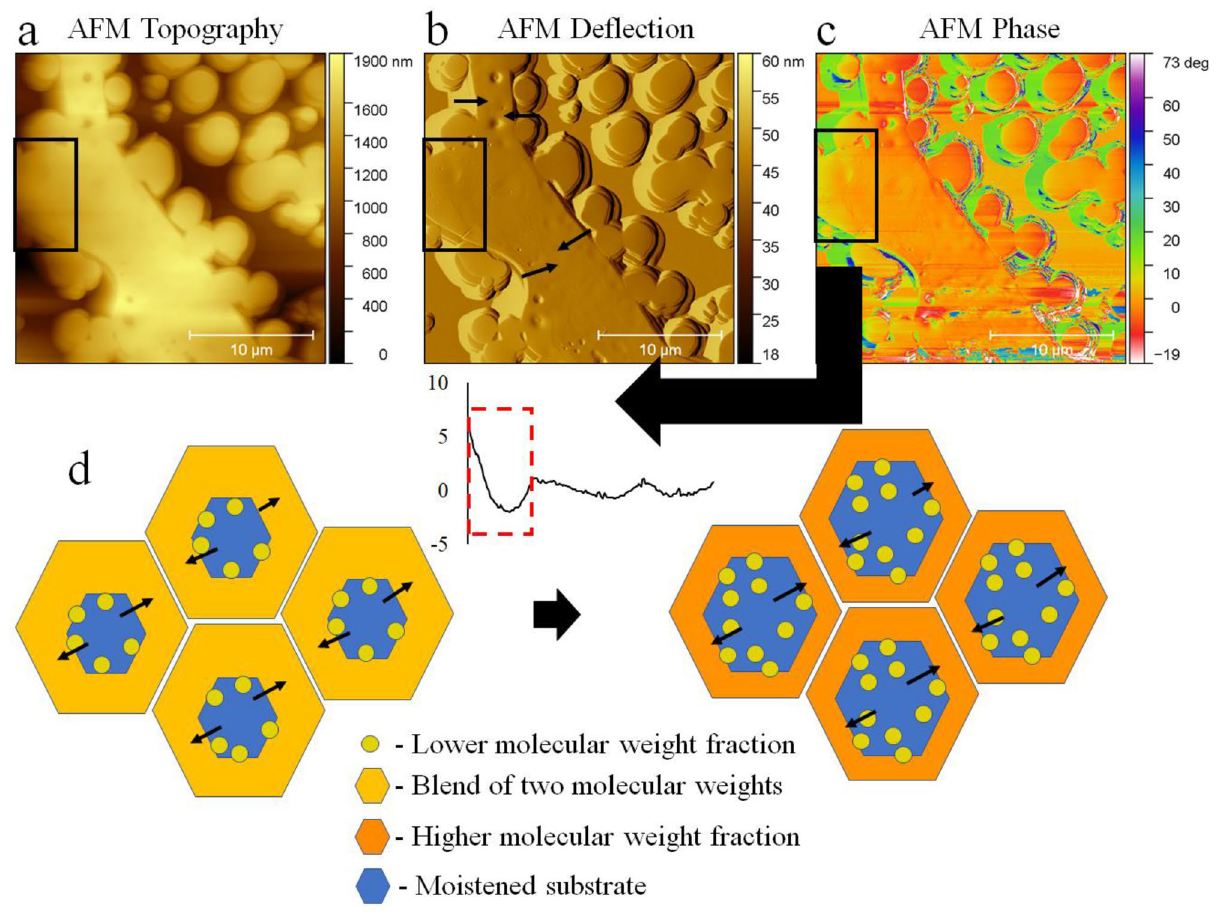
Figure 14. AFM magnification of the cell border of the 20 kDa and 200 kDa 75/25 w/w% blend spun at Rh 75%. The black rectangle indicates the separation of different phases. The same region is shown in the form of ( a ) topography, ( b ) AFM deflection, the direction of dewetting is indicated by the black arrows; ( c ) AFM phase image, an arrow indicates the phase signal difference presented as the averaged cross-section of the marked region (black box); ( d ) schematic illustration depicting proposed formation mechanism of the honeycomb; Convection inside the liquid film led to cells formation, condensation of water led to film rupture (Blue). Subsequently, the recess of the film occurred. At the interface between the rupture area and the receding film, separation of the lower molecular fraction arises (yellow). Subsequently, the cell borders were reinforced by the remaining high molecular weight fraction